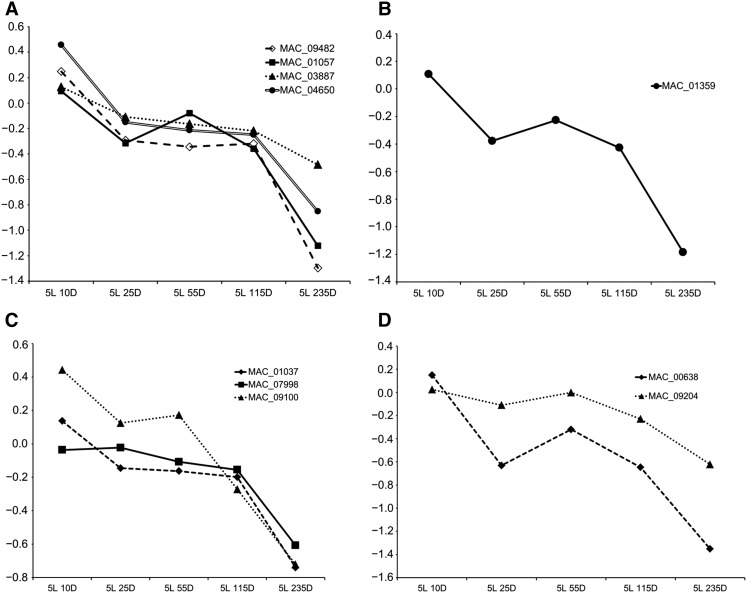
Light downregulated proteins involved in translation, including (A) eIF3 subunits M (MAC_01057), E (MAC_09482), K (MAC_04650), and F (MAC_03887); (B) the eIF5A-activating enzyme deoxyhypusine hydroxylase (MAC_01359); (C) cytosolic ribosomal proteins P0 (MAC_01037), S14 (MAC_07998), and S29 (MAC_09100); and (D) mitochondrial ribosomal proteins L12 (MAC_00638) and MRP2 (MAC_09204). Values in y-axis are log2 fold-change relative to DD.